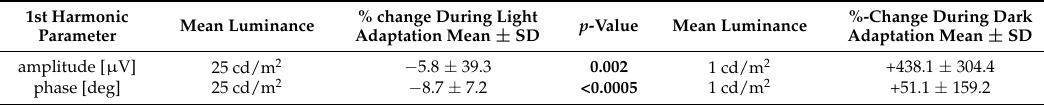
Figure 5. Light and dark adaptation recorded with the flicker adaptation protocol. ( A ) The flicker ERG response at 0 (thin curve) and 11 min. (thick curve) after onset of the 25 cd/m 2 mean luminance; ( B ) Thick curves represent flicker ERGs at 0, 5 and 23 min after the onset of the 1 cd/m 2 mean luminance. Thin curves represent reference measurements at 1 cd/m 2 obtained at the beginning of the session; ( C ) Amplitudes (upper plot; means ± SD) and phases (lower plot) of the fundamental component as a function of adaptation time (red open triangles: 25 cd/m 2 ; black closed circles: 1 cd/m 2 ). The gray zone is the 95% interval of the reference measurements. n light adaptation = 8, n dark adaptation = 8. Table 3. Summary of the first harmonic analyses. Changes for the amplitude and phase of the photopic first harmonic were tested for significant changes during light adaptation with a Friedmann-test. Due to the bad-signal-to noise ratio, some of the data for the dark adaptation had to be excluded. Therefore no statistical tests could be performed on the mesopic data. Significance level was corrected via the Bonferroni method: α Bonferroni = 0.025. p -Values that were significant after the Bonferroni correction are